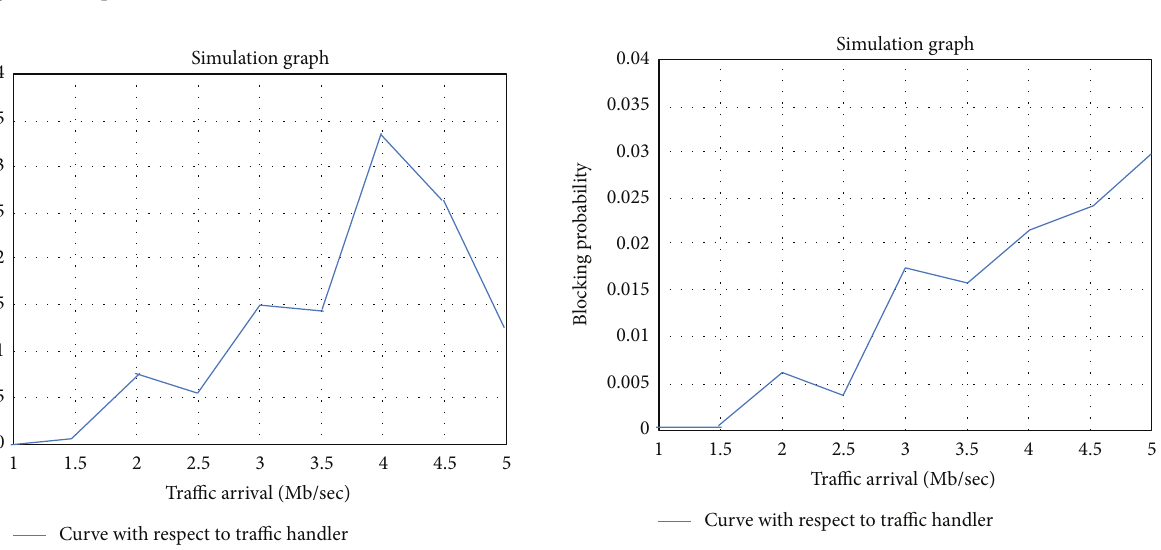
Figure 4: Blocking probability versus arrival rate with respect to incoming service requests.